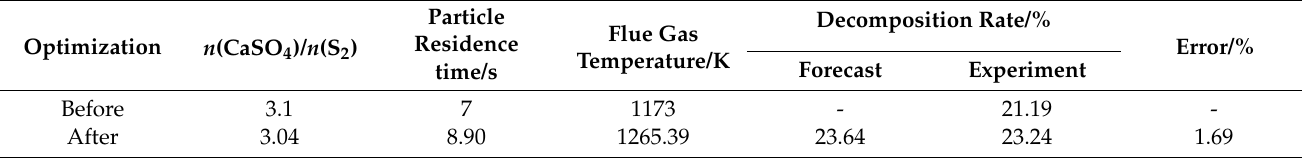
Table 8. Process parameters before and after